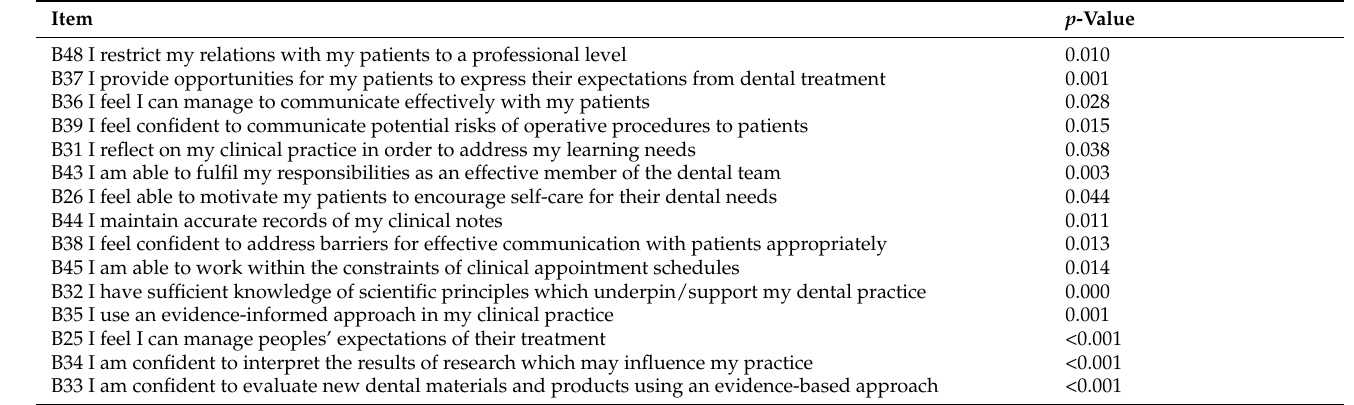
Table 4. Association between Gender and Item Responses for Part B: Specific p -values from Chi- Squared tests of association for items showing a statistically significant association between Gender and Item Responses for Part B.